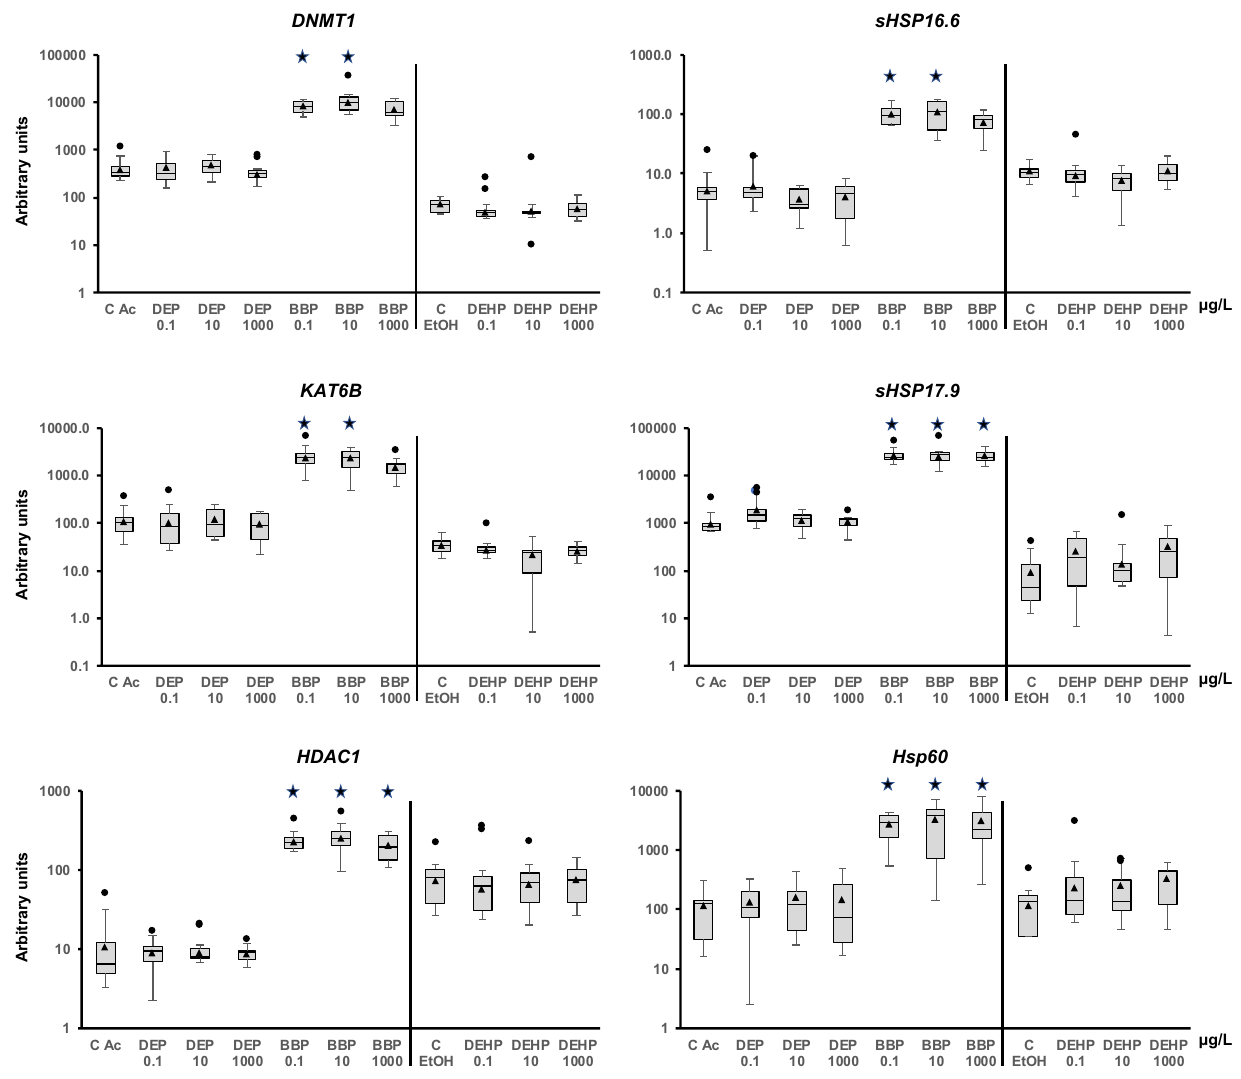
Figure 5. The mRNA levels of genes involved in epigenetic regulation ( DNMT1 , KAT6B , and HDAC1 ) and stress response ( sHsp16.6 , sHsp17.9 , and Hsp60 ) in adult Physella acuta after in vivo exposure to diethyl phthalate (DEP), benzyl butyl phthalate (BBP), and bis-(2-ethylhexyl) phthalate (DEHP) for 1 week at 19 °C. The mRNA levels were normalized using rpL10 , Act , PFKFB2 , and GAPDH as reference genes. Treated animals were compared to solvent-exposed (EtOH, acetone) controls. Whisker boxes are shown (n = 9 individuals per box). The horizontal line within the box indicates the median, and the 25th and 75th percentiles are indicated by the boundaries of the box. The whiskers represent the highest and lowest results. The small triangle inside the box denotes the mean, and the outliers are shown (circles). Significant differences to the respective controls (asterisk) are indicated ( p <